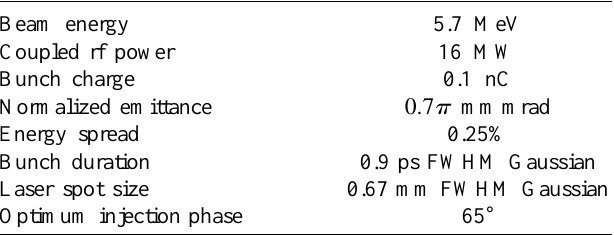
TABLE I. X -band rf gun design parameters.